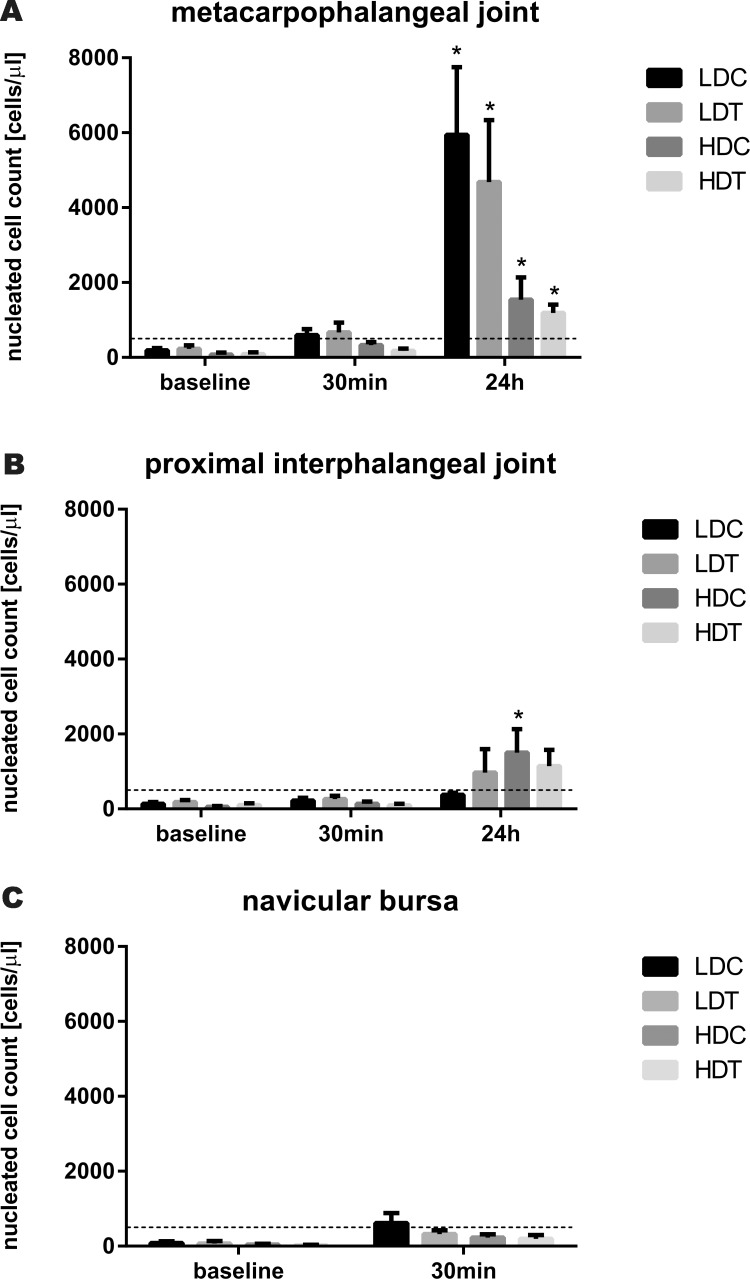
Bar graphs illustrating synovial fluid total nucleated cell counts after IVRLP with tiludronate or saline.Synovial fluid total nucleated cell counts over time after IVRLP with 0.5 mg (LDT) or 50 mg (HDT) tiludronate diluted in 50 ml saline in one randomly assigned forelimb or with 50 ml saline in the contralateral forelimb as control for the low dose (LDC) or as control for the high dose of tiludronate (HDC). Synovial fluid was sampled from the metacarpophalangeal joint (A), the coffin joint (B) and the navicular bursa (C). The dotted line represents the upper limit of the normal reference interval (Mahaffey, 2002). An asterisk indicates significant difference (P < 0.05) from baseline measurement. Error bars represent SEM.